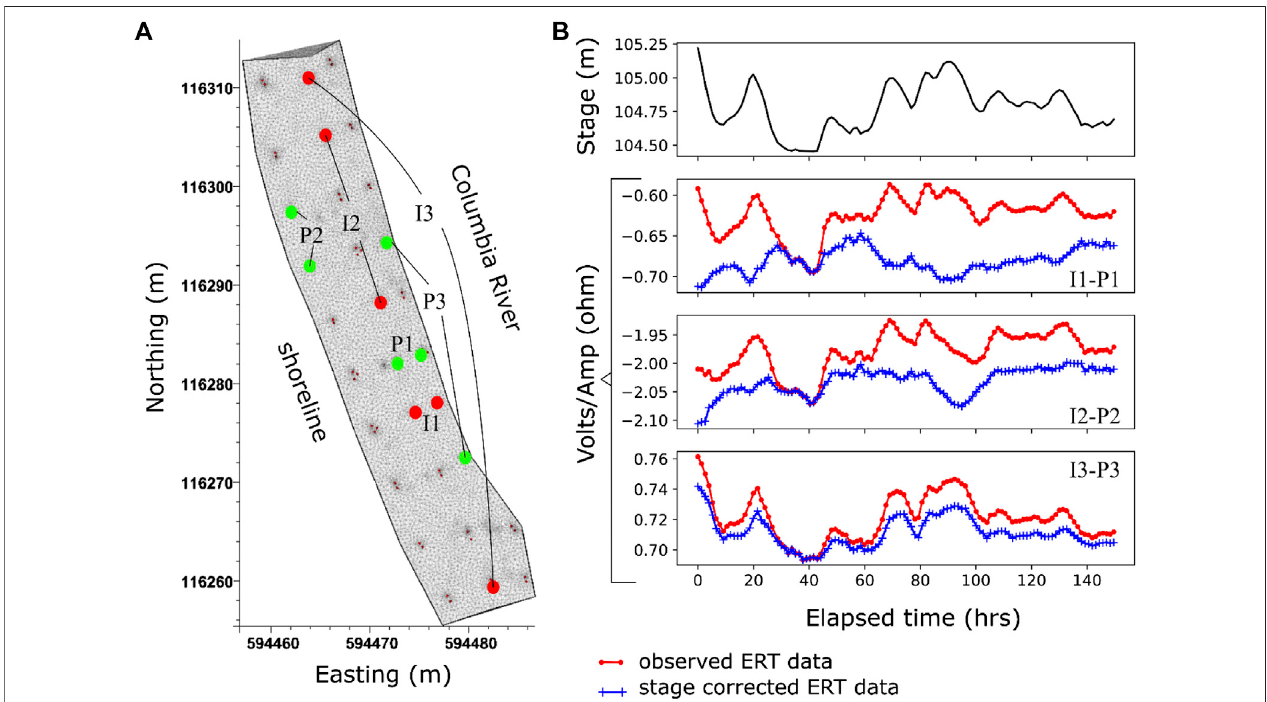
FIGURE 3 | (A) Locations of current injection electrodes (I1, I2, and I3) and potential measurement electrodes (P1, P2, and P3) for ERT data time series shown in (B) . (B) StageelevationandERTobservedandstage-correctedmeasurementtimeseries(i.e.,I1-P1isthevoltageobservedacrosselectrodes pairP1givenacurrentof 1 A injection across current pair I1). Each marker indicates an ERT survey